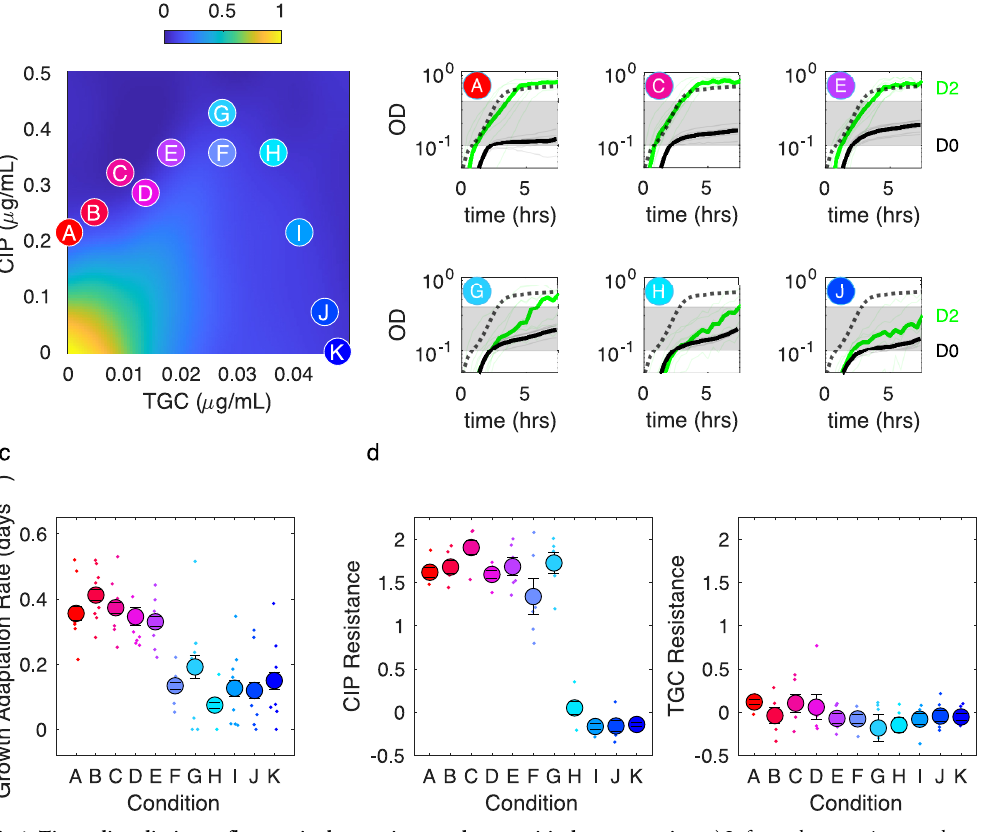
Fig 4. Tigecycline eliminates fluoroquinolone resistance above a critical concentration. a) Left panel: per capita growth rate of ancestral populations as a function of tigecycline (TGC) and ciprofloxacin (CIP) concentrations. Circles correspond to different selecting conditions along a contour of constant inhibition. b) growth curves for the first (black) and last (green) days of evolution for six of the 11 selecting conditions. c) Average rate of growth adaptation over the course of the evolution for each condition. d. Resistance to CIP (left) and TGC (right) for isolates on the final day of evolution. Resistance is defined as the log 2 -scaled fold change in IC 50 of the resistant isolate relative to ancestral cells (positive is increased resistance, negative is increased sensitivity). In all plots, light transparent lines or small points correspond to individual populations. Darker lines and larger circles represent means taken across populations. Error bars are ± standard error of the mean